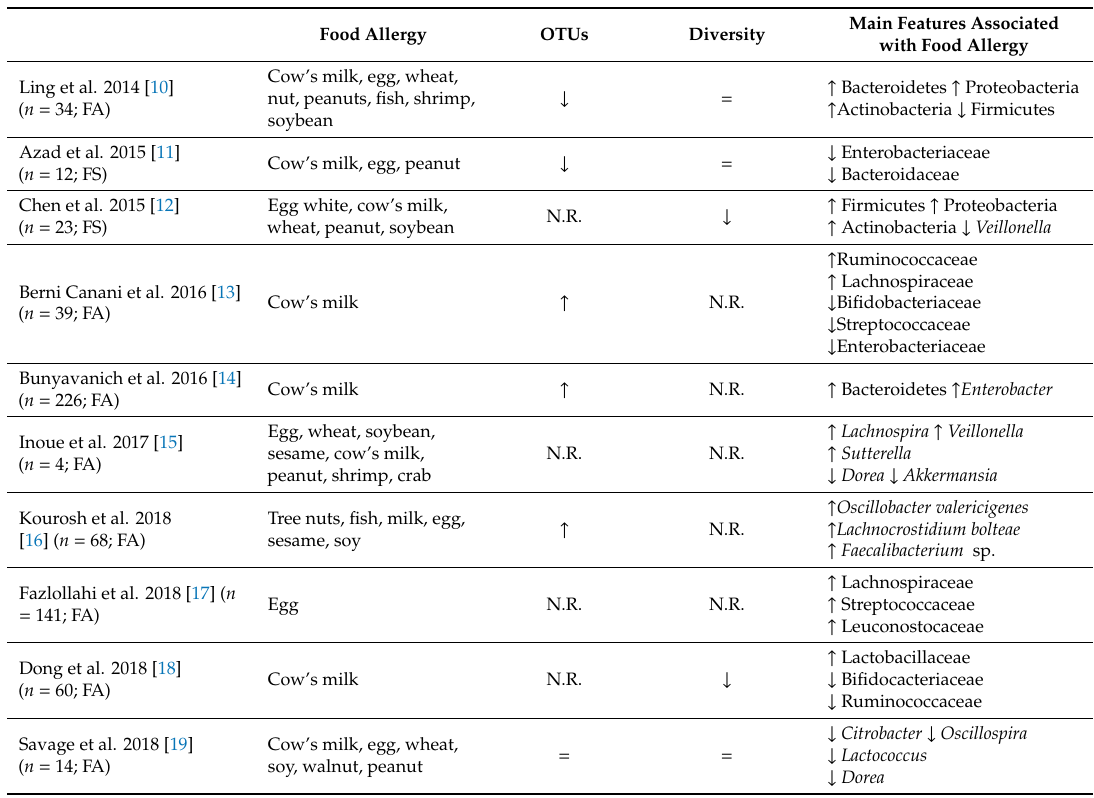
Table 1. Main gut microbiome di ff erences in 16S-rRNA-sequencing-based studies between pediatric patients with and without